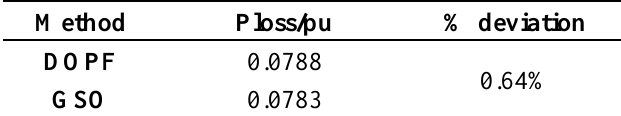
Table 13. Comparison of results between two